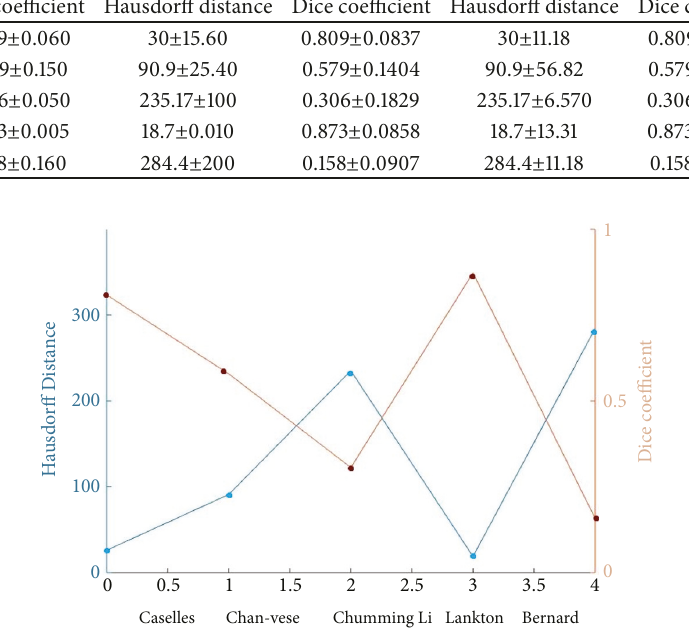
Figure 3: Graphical representation of mean average values of similarity index